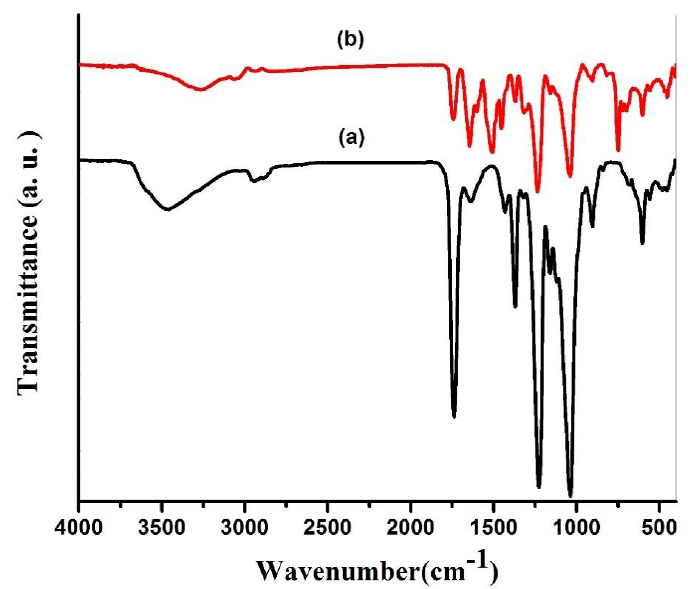
Figure 11. ATR-FTIR spectra of ( a ) CTA/0.3% GO substrate and ( b ) the PA-TFC membrane.